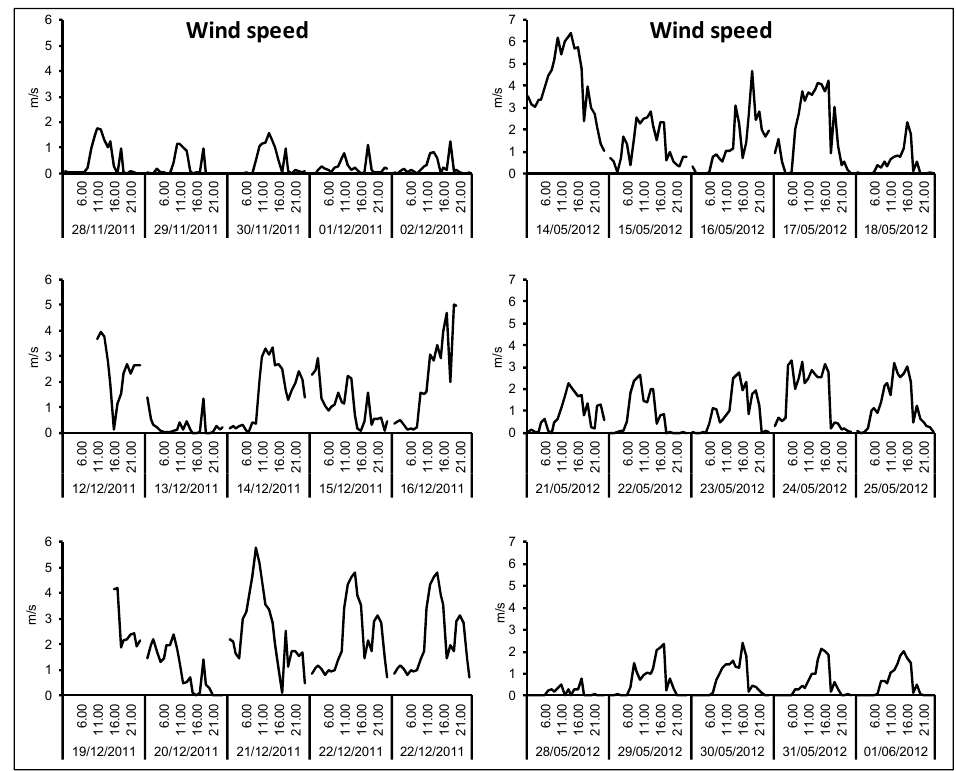
Figure A3. Time pattern of wind speed during the winter and spring/summer